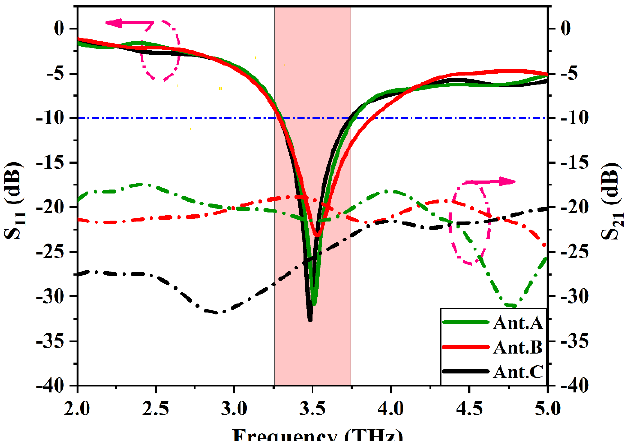
Figure 9. S − parameters (S 11 and S 21 ) of the three different MIMO